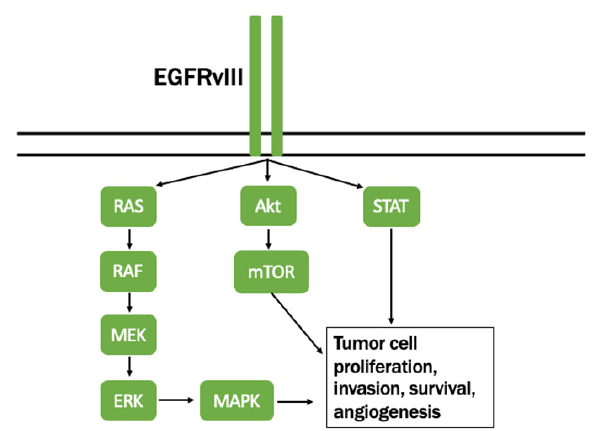
Figure 1. EGFRvIII signaling pathways.